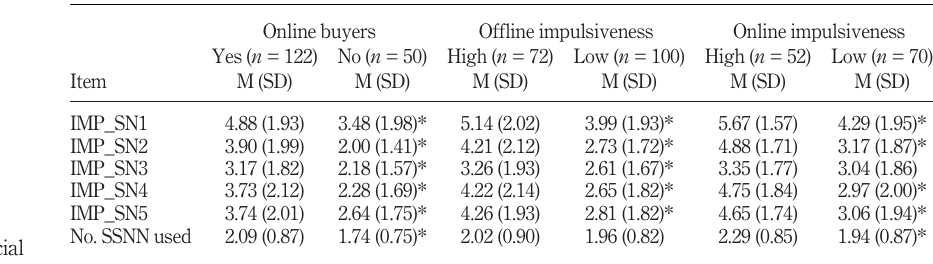
Table VI. Influence of social networks on impulse buying